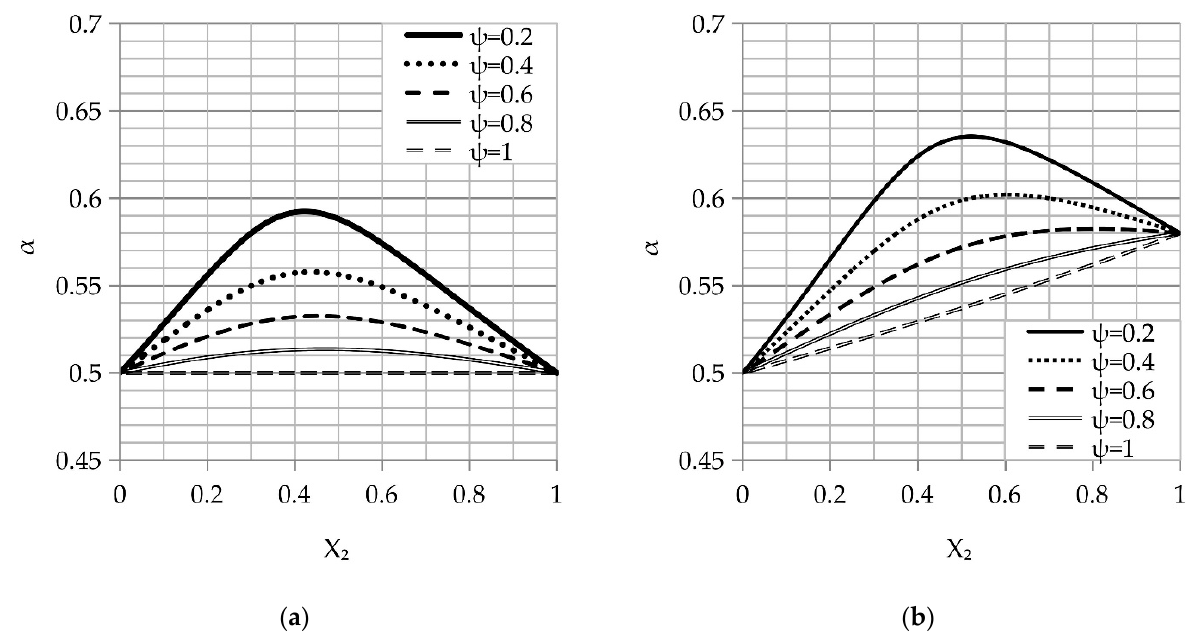
Figure 1. Plots of the actual density of the double fracture packing ( α ) as a function of the second fracture (X 2 ) content in the granular mix ( ψ = d 2 / d 1 ) at the same packing process (pouring compaction index ( K = 4.1) for: ( a ) the same packing density of the monodisperse granules and ( b ) the different packing density of the monodisperse